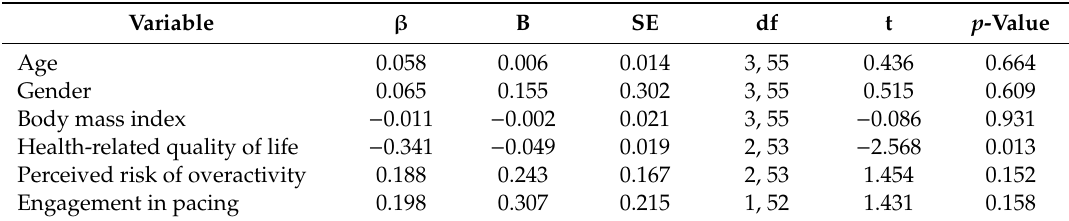
Table 3. Hierarchical linear regression model showing the relationship between engagement in pacing and